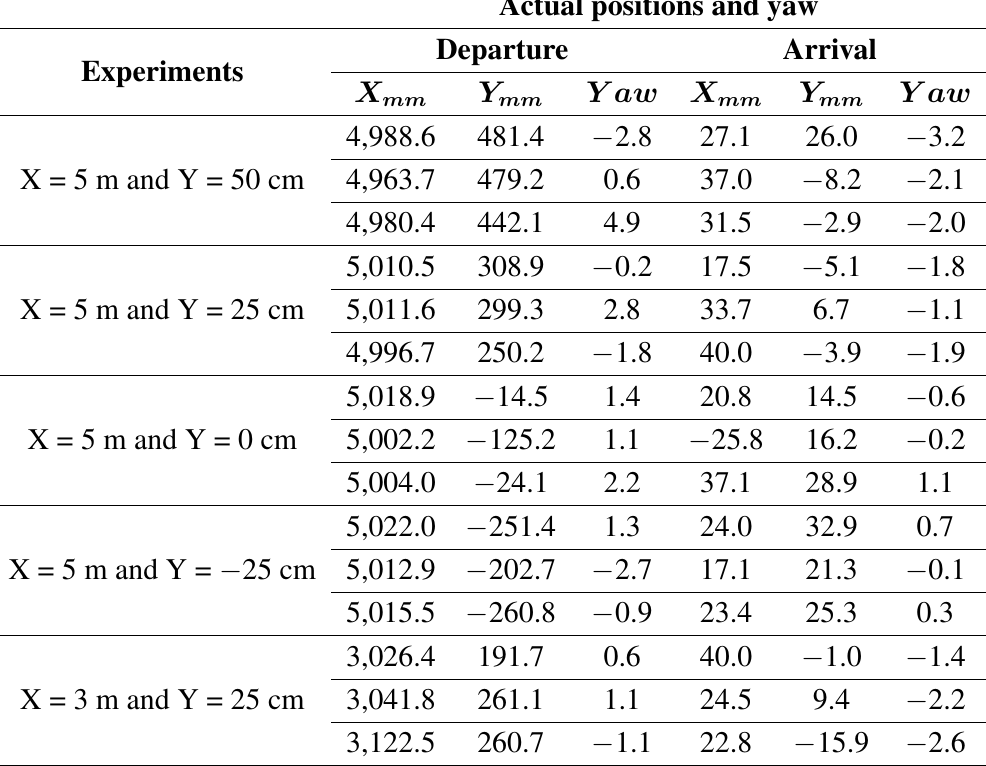
Table 2. Departure and arrival points in different situations. Actual positions and